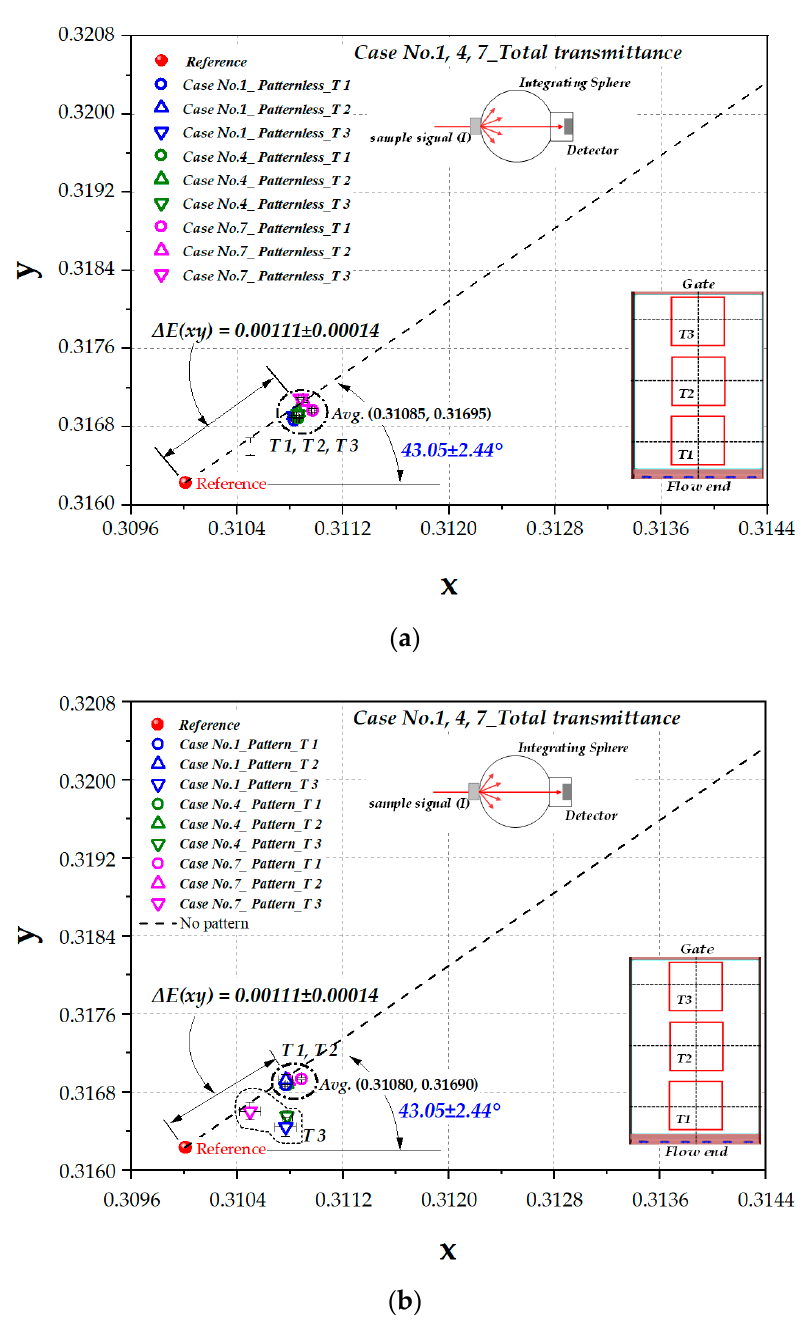
Figure 7. The representation of color shift from total transmittance shown in CIE1931 color space: ( a ) patternless LGP (Case Nos. 1, 4, and 7); ( b ) patterned LGP (Case Nos. 1, 4, and 7).